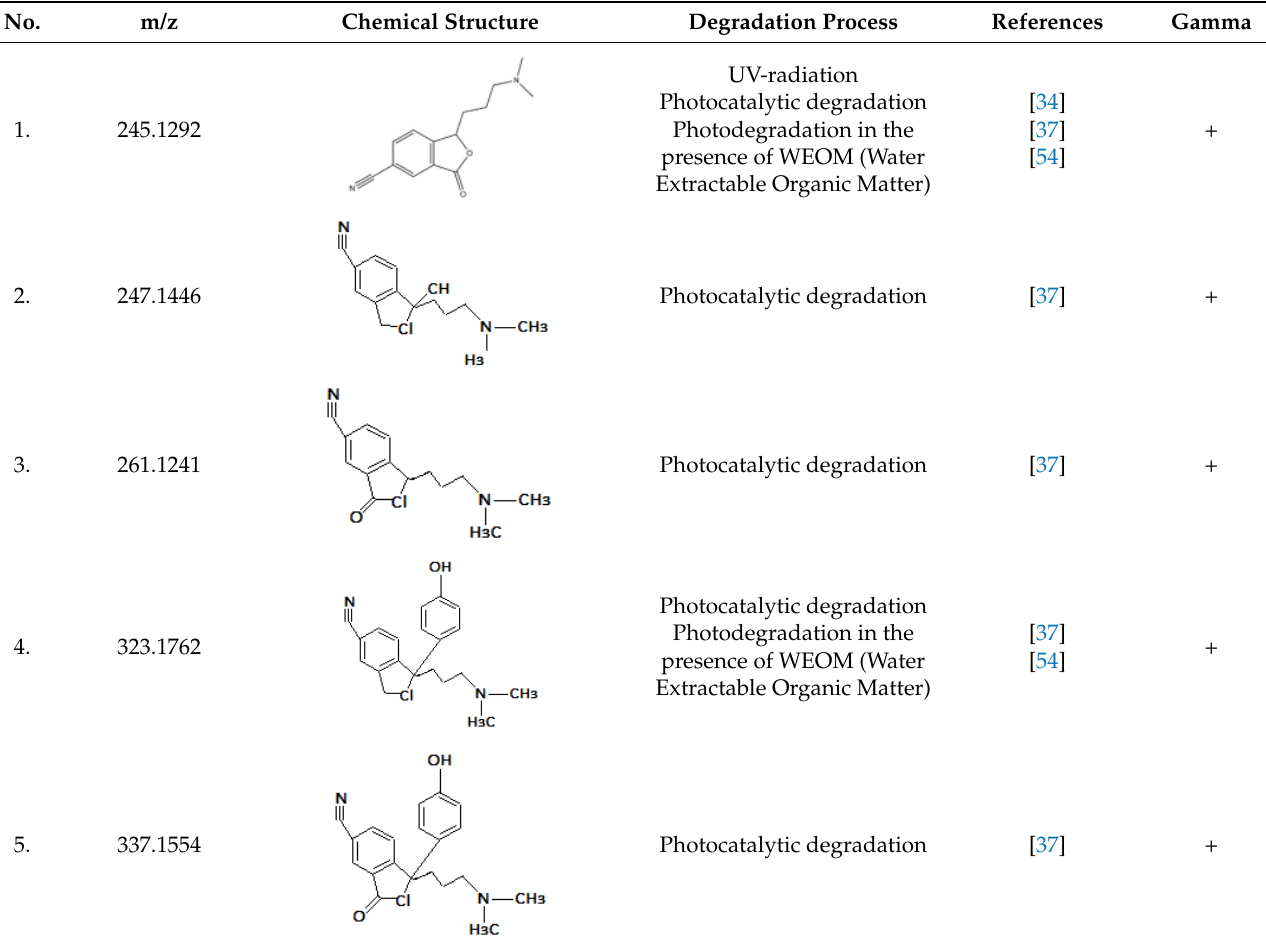
Figure 10. Formation of selected radiolytic degradation product of citalopram. Table 3. Detected products of citalopram degradation.